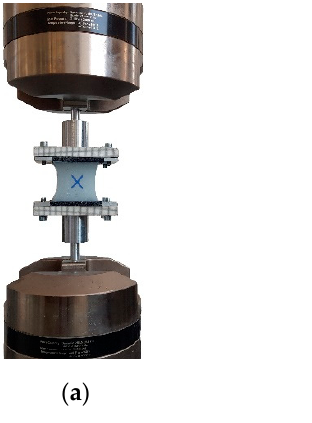
Figure A2. Experimental cyclic stress–strain relationship of the PlatsilGel OO30 material.